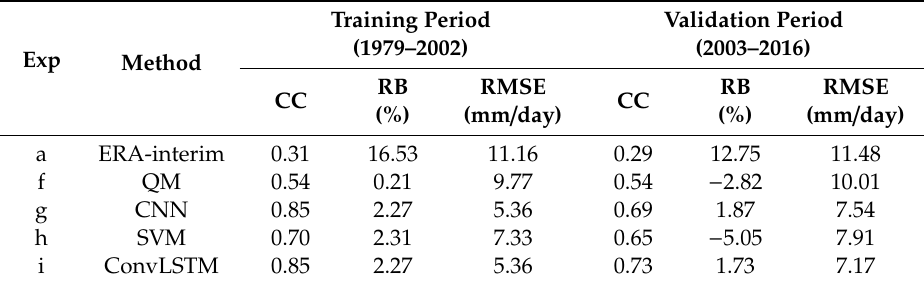
Table 3. Performance of downscaled precipitation using di ff erent downscaling methods.